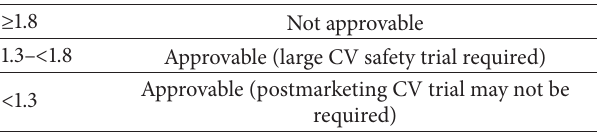
Table 5: Upper bound 2-sided 95% confidence interval cut-off for approval